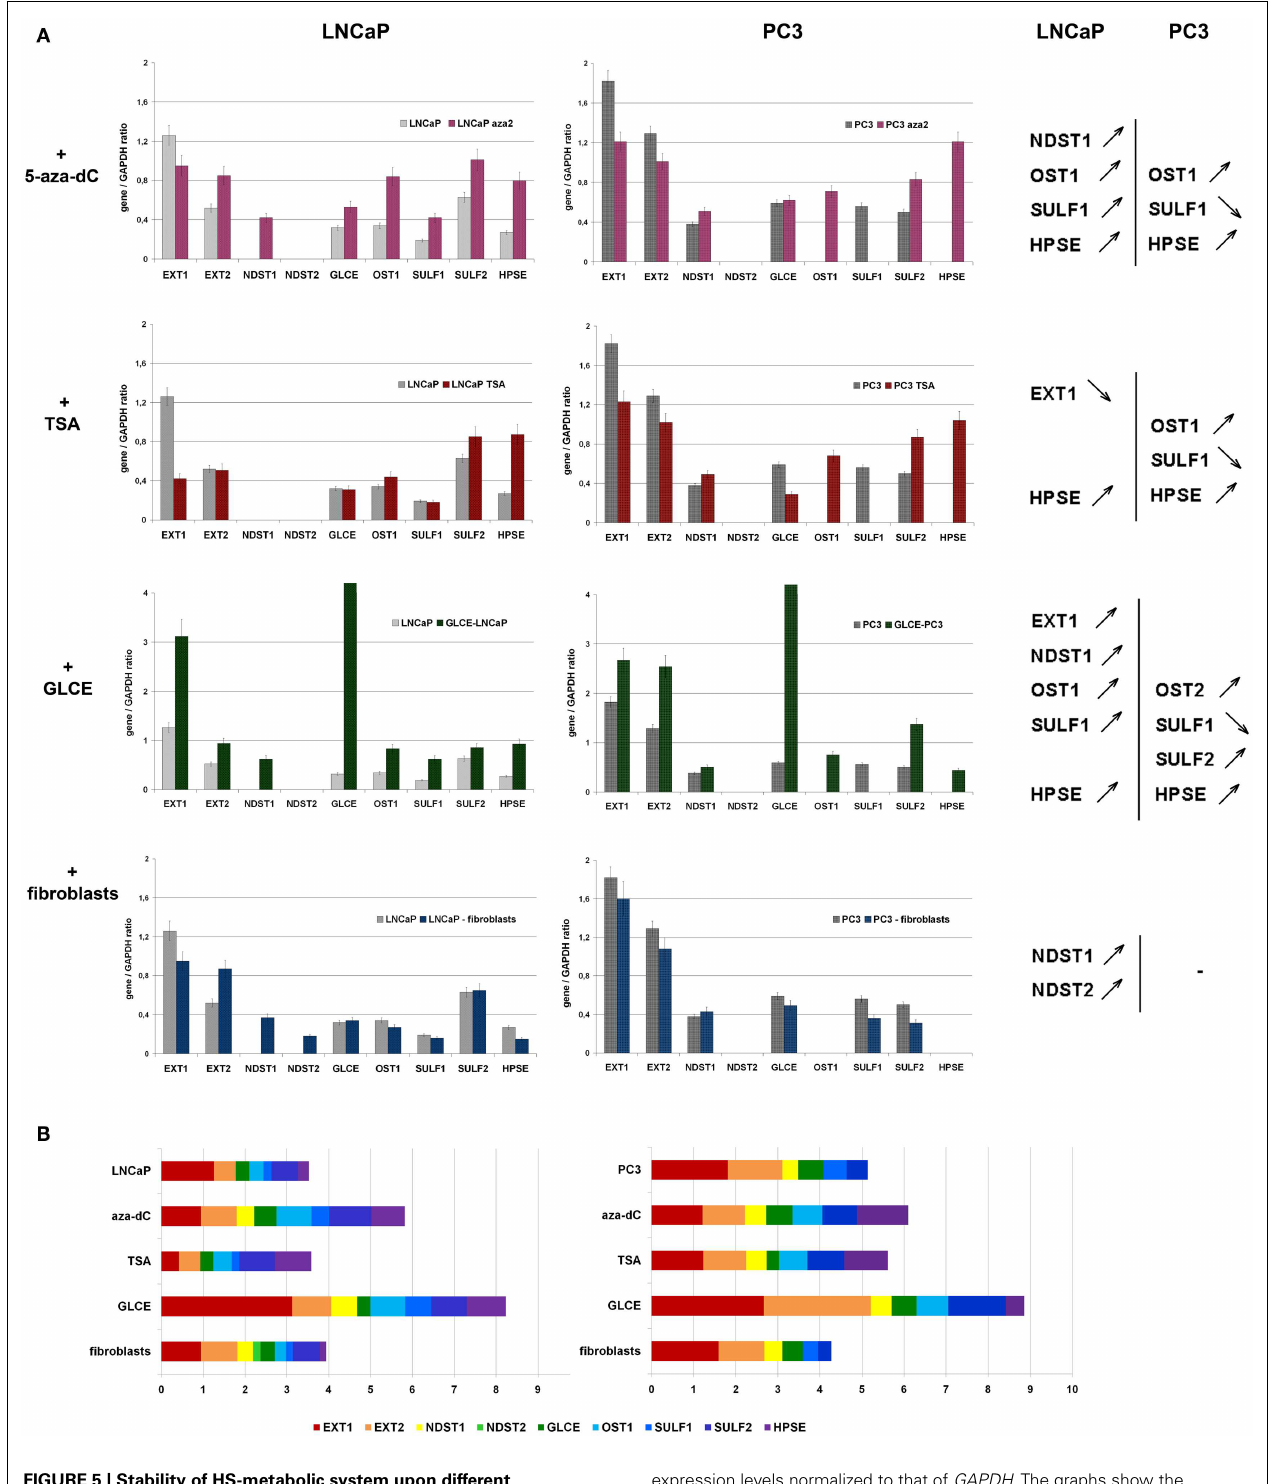
FIGURE 5 | Stability of HS-metabolic system upon different external and internal stimuli . (A) Expressions of key HS metabolism-involved genes in LNCaP and PC3 prostate cancer cells before and after the treatments with 5-aza-deoxycytidine ( + 5-aza-dC), Trichostatin A ( + TSA), ectopic over-expression of GLCE ( + GLCE), co-culture with human fibroblasts ( + fibroblasts).The genes